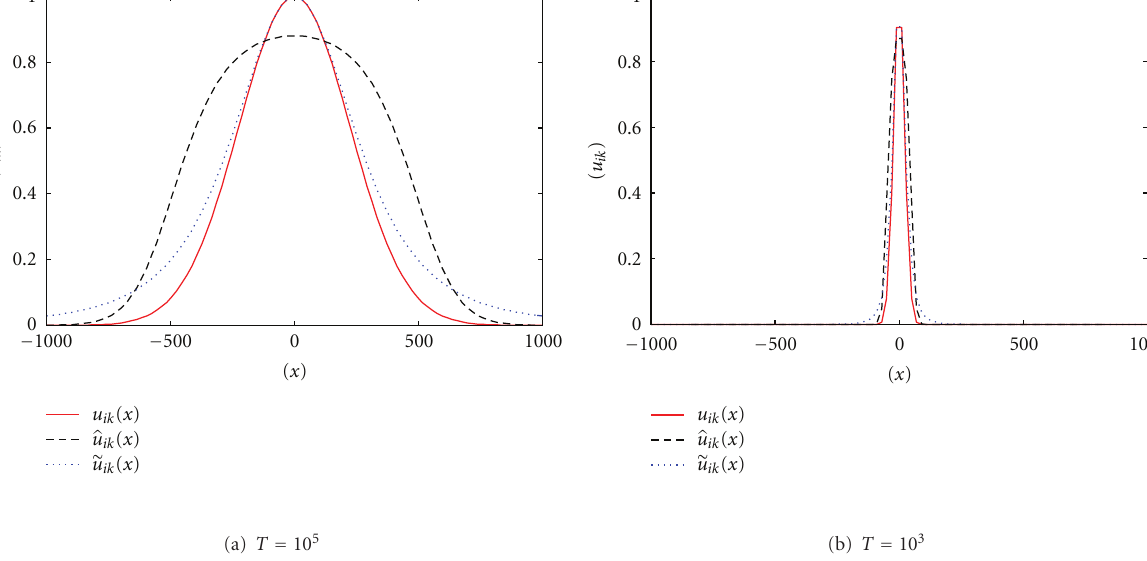
Figure 2: The plots of the membership functions u ik , u i k and (cid:11) u ik at (a) high and (b) low temperature ( n = 1, c = 2, q = 1 . 5, α k = −